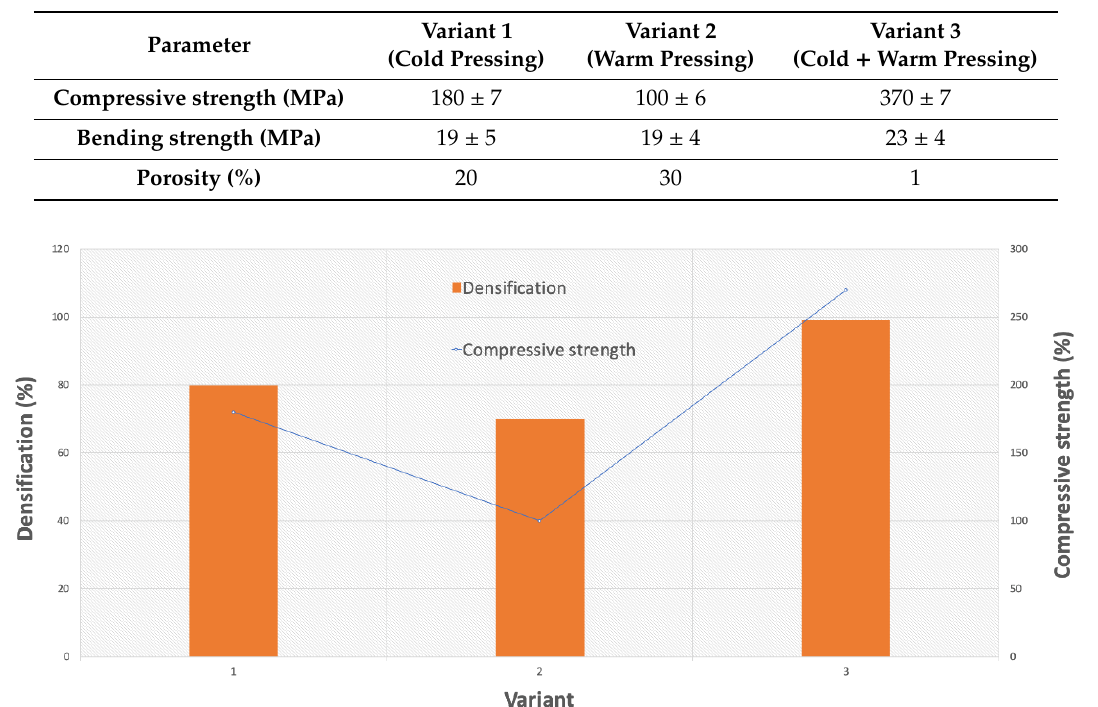
Table 1. Mechanical properties of the 80% HAP NPs + 20% PLA composite for different variants.